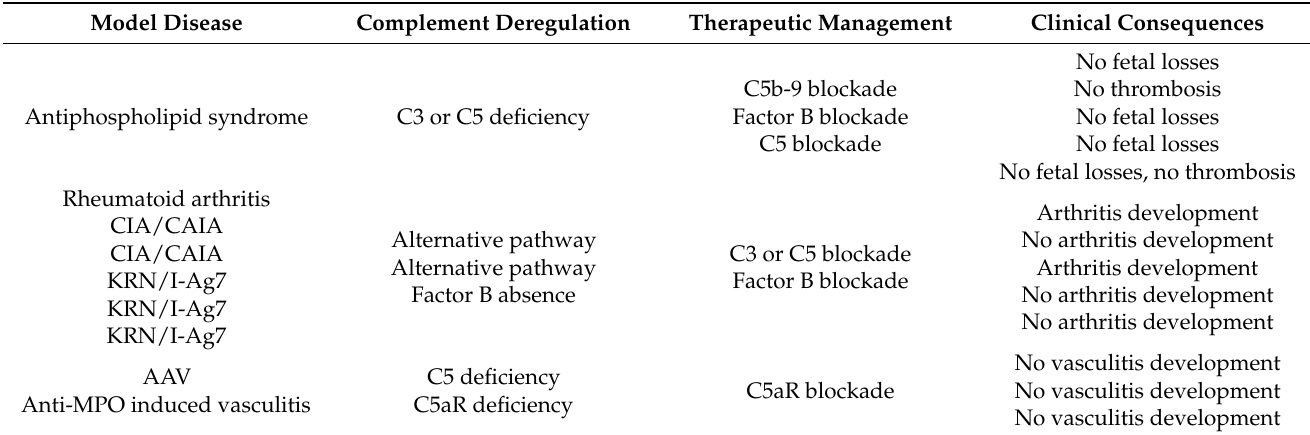
Table 1. Complement deregulation in autoimmune animal